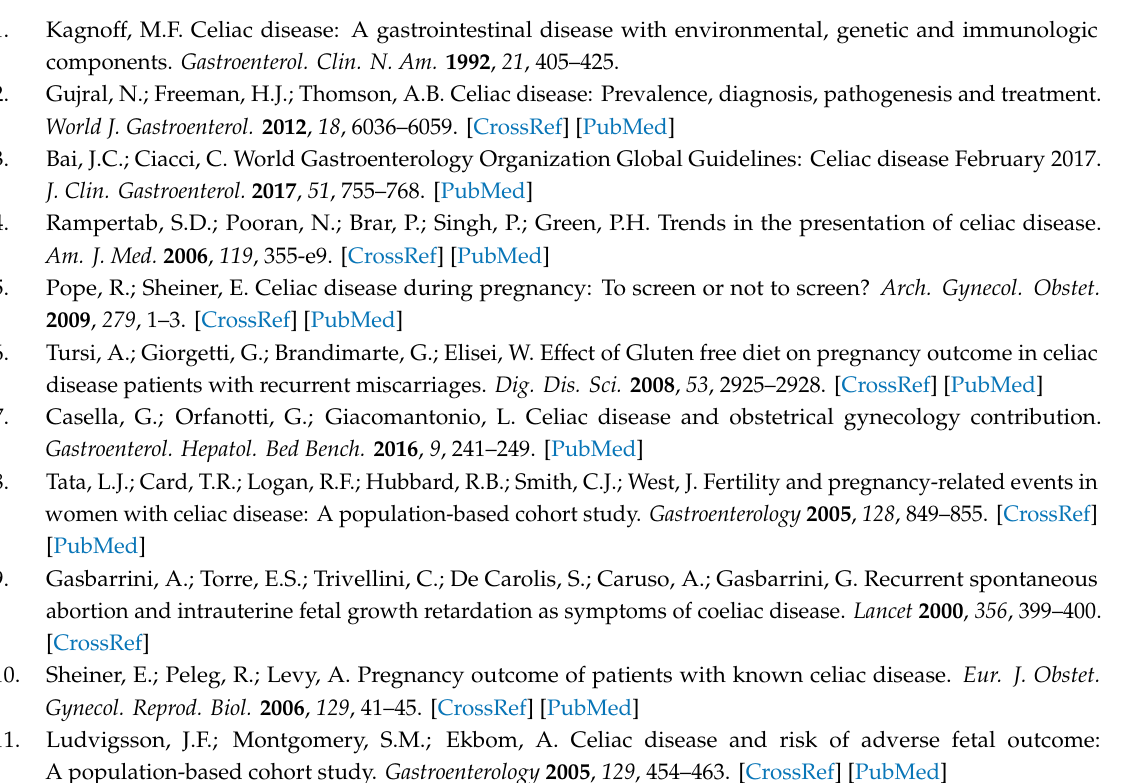
Table S1: International classification of diseases, ICD-9 codes for gastrointestinal morbidities accounted